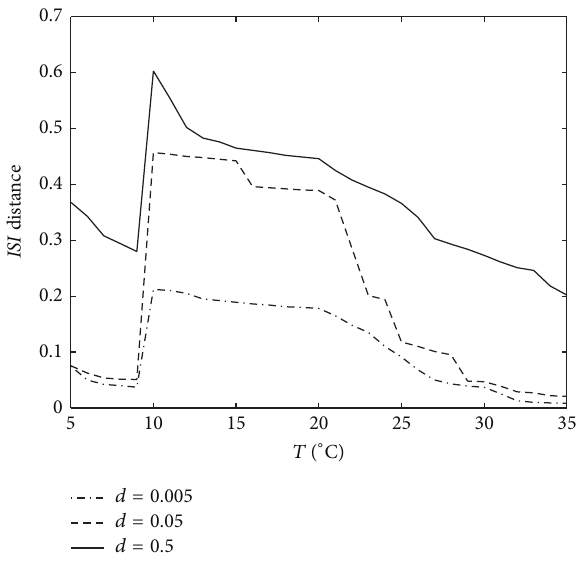
Figure 2: The change of ISI distance as a function of temperature 𝑇 at different noise densities. Solid line: 𝑑 = 0.5 ; dashed line: 𝑑 = 0.05 ; dot-dashed line: 𝑑 = 0.5